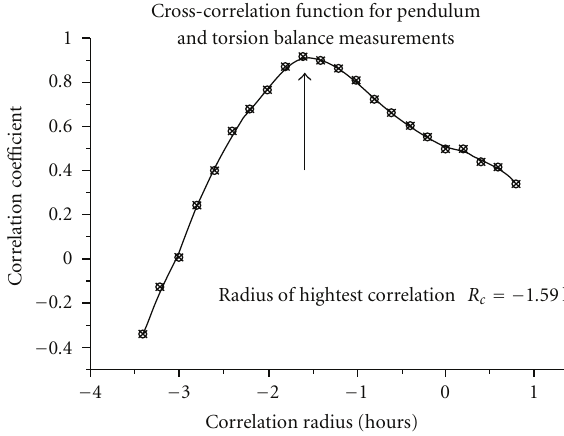
Figure 7: Cross-correlation function for the series of pendulum and torsion